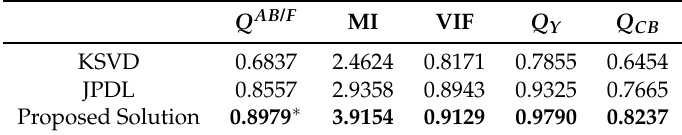
Table 3. Fusion Performance Comparison - 3 of Multi-focus Fluorescence Image